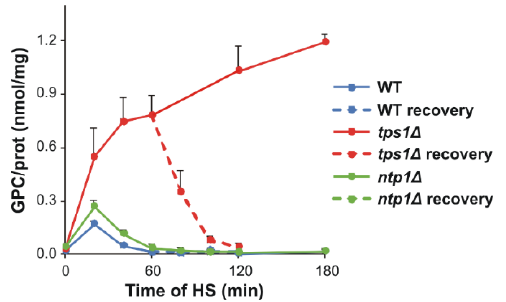
Figure 8. Kinetics of glycerophosphocholine accumulation due to heat stress (HS). Yeast cells were heat-stressed at 40 °C for 0–180 min or, after 60 min of stress, were left to recover at 30 °C for 60 min. Data are presented as mean ± SD, n = 3 (independent experiments); for significance values, see Table S2. WT, wild-type; tps1 Δ , trehalose-deficient; and ntp1 Δ , trehalase-deficient S. pombe strains; GPC, glycerophosphocholine.